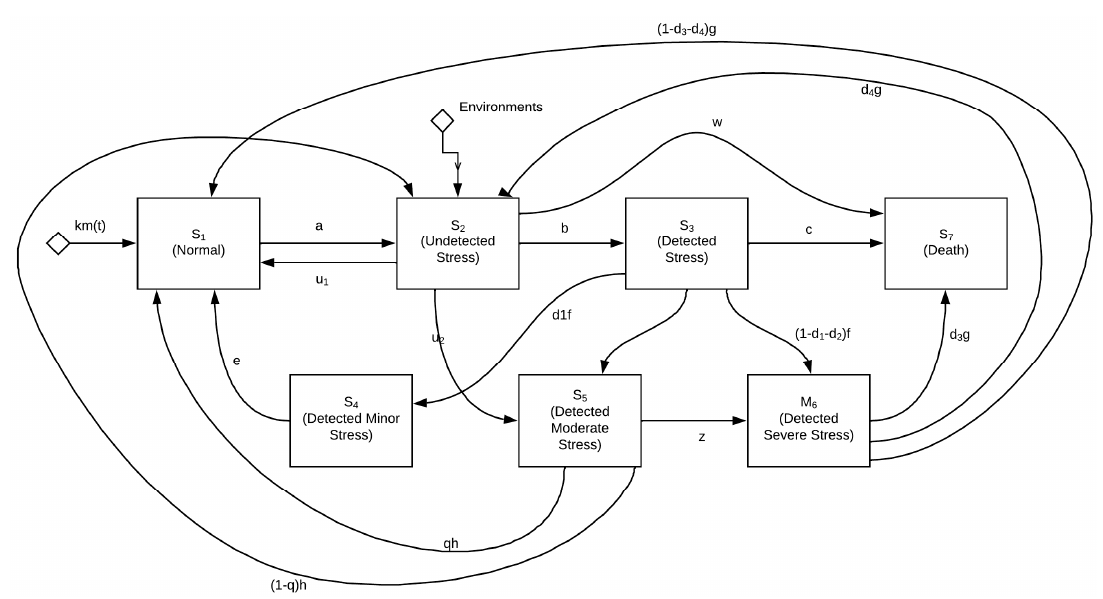
Figure 1. The proposed mental stress time delay model